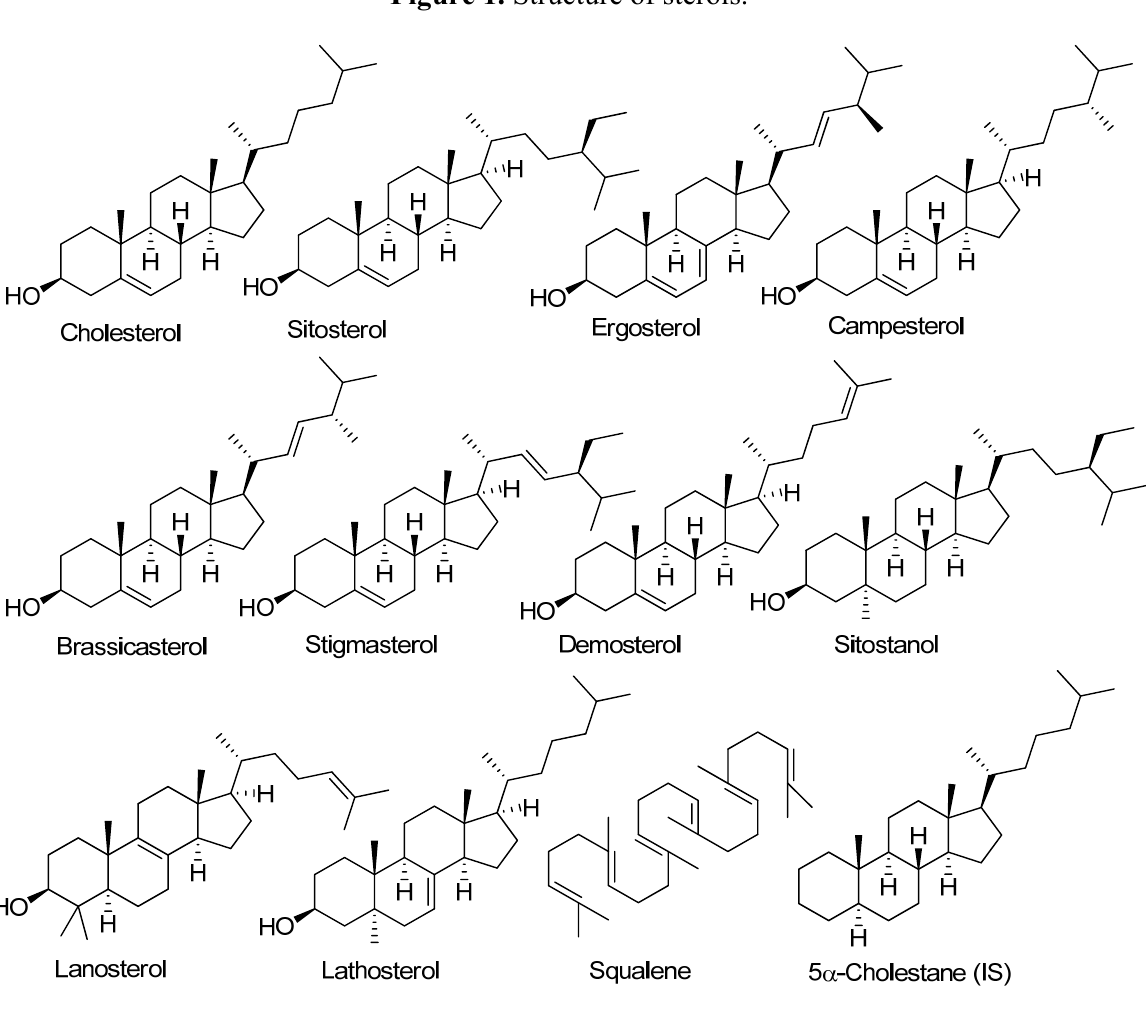
Figure 1. Structure of